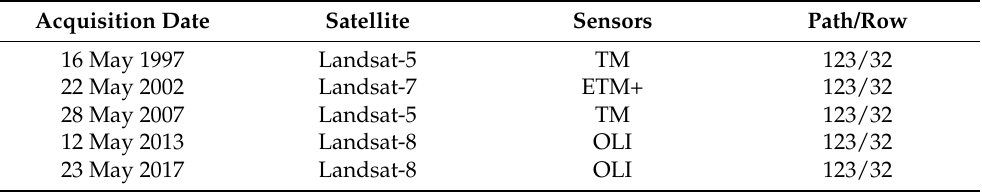
Table 1. Landsat images that utilized for impervious surface